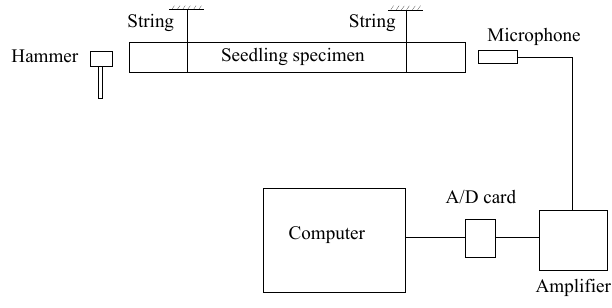
Figure 4. Test setup of the acoustic resonance method.